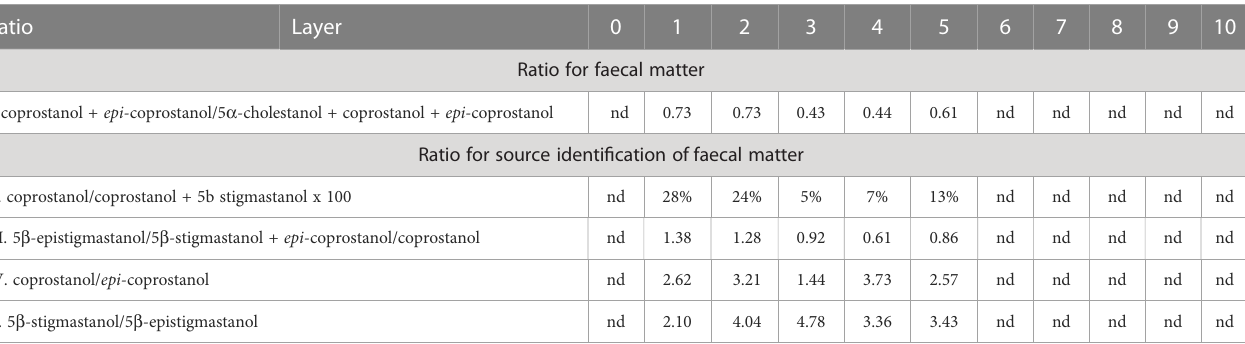
TABLE 1 Summary of faecal steroid